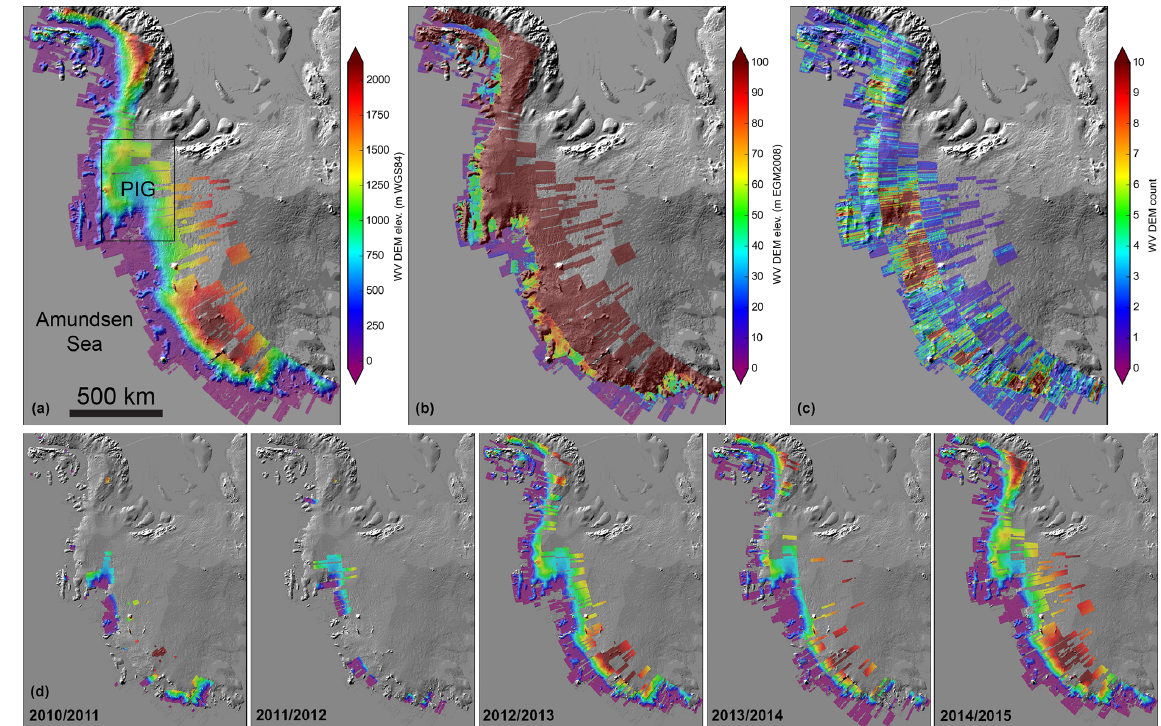
Figure 1. Cumulative and annual DEM composites for West Antarctica. (a) Weighted-average composite of ∼ 3000 WorldView/GeoEye stereo DEMs from 2010 to 2015, overlaid on Bedmap2 shaded relief map. Total cumulative 2m DEM coverage is 4.1 millionkm 2 . The black box shows the location of Fig. 2. (b) DEM composite with elevation values relative to EGM2008 geoid (approximates mean sea level) and the color is stretched to show surface elevation of floating ice shelves. (c) Total count of DEMs for the 2010–2015 time period and (d) annual DEM mosaics with same color scale as panel (a) . Note the increased annual coverage over time, with good coverage of PIG ice shelf in all years. Projection is Antarctic polar stereographic (EPSG:3031).